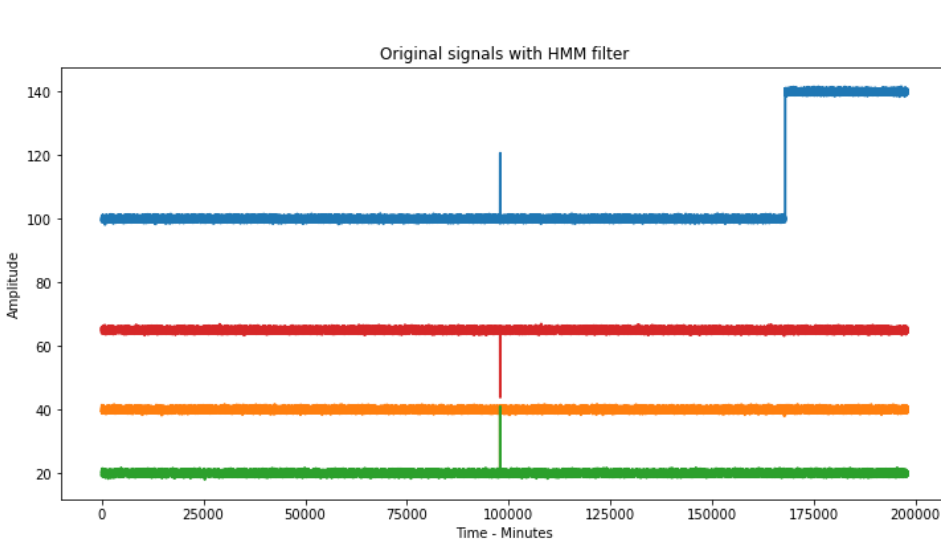
Figure 10. Original signal with overlapping HMM states.